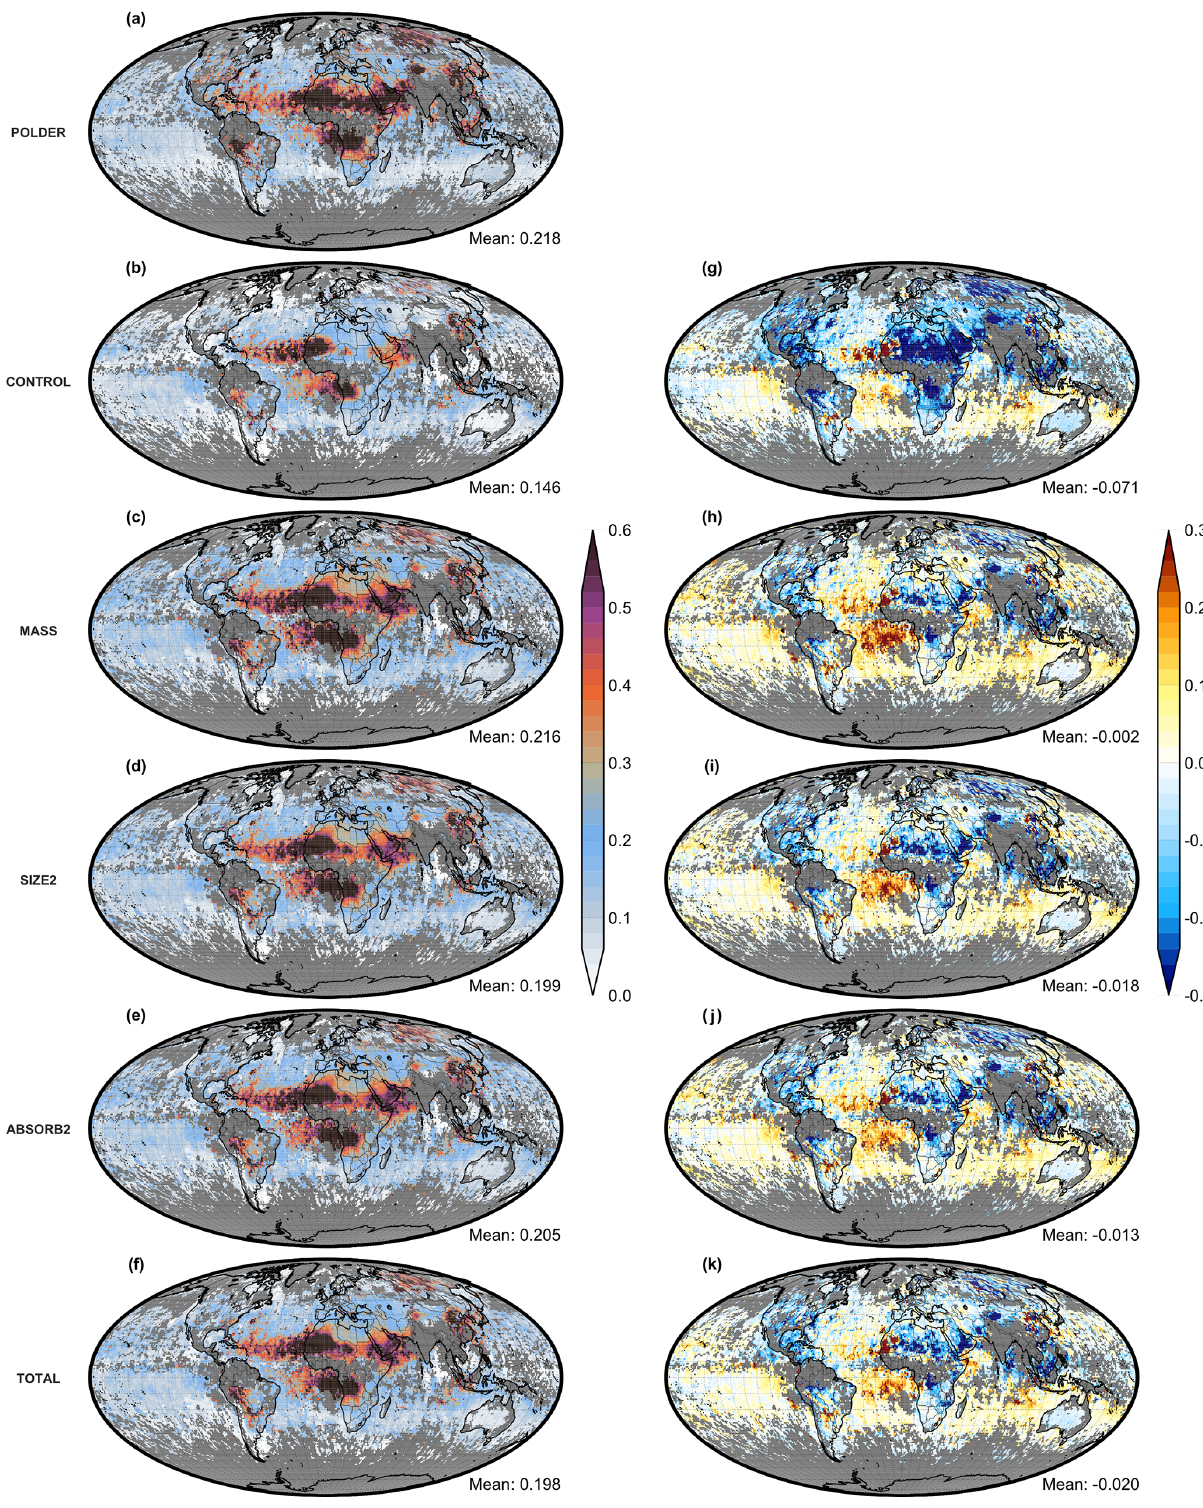
Figure 5. Aerosol Optical Depth at 550nm for (a) POLDER, the (b) CONTROL, (c) MASS, (d) SIZE2, (e) ABSORB2, (f) TOTAL experi- ments and their differences (model – POLDER; g–k ). All fields are spatiotemporally collocated to the available measurements of POLDER for the period 20 July to 28 August 2006. Grey-filled grid cells indicate the absence of any valid POLDER measurements for the study period.